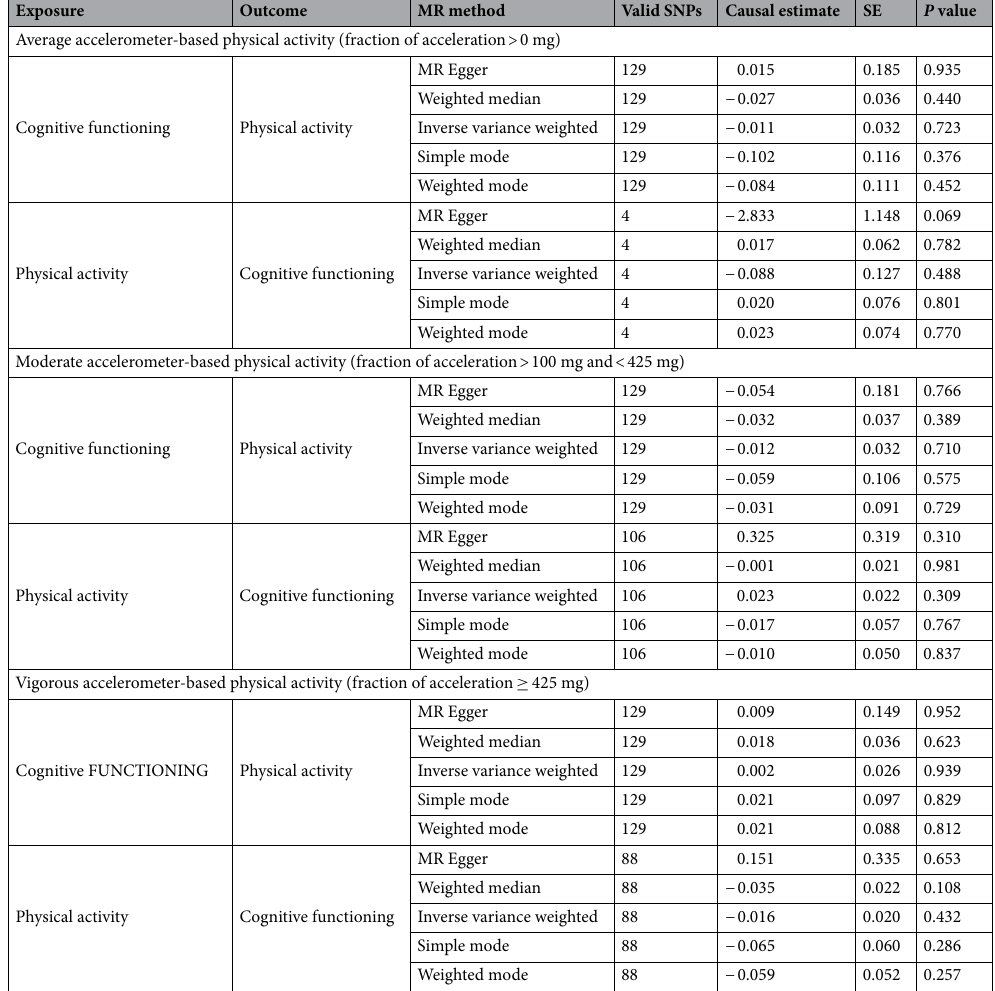
Table 2. Standard Mendelian Randomization (MR) results for the association between accelerometer- based physical activity and general cognitive functioning. Causal estimates from 5 standard Mendelian Randomization (MR) methods on alternating exposure and outcome traits. For both moderate and vigorous physical activity as exposure, the cutoff was decreased to 6.33e − 5 because of the low number of genome wide significant single nucleotide polymorphisms (SNPs) to use as instruments. Corrected α =